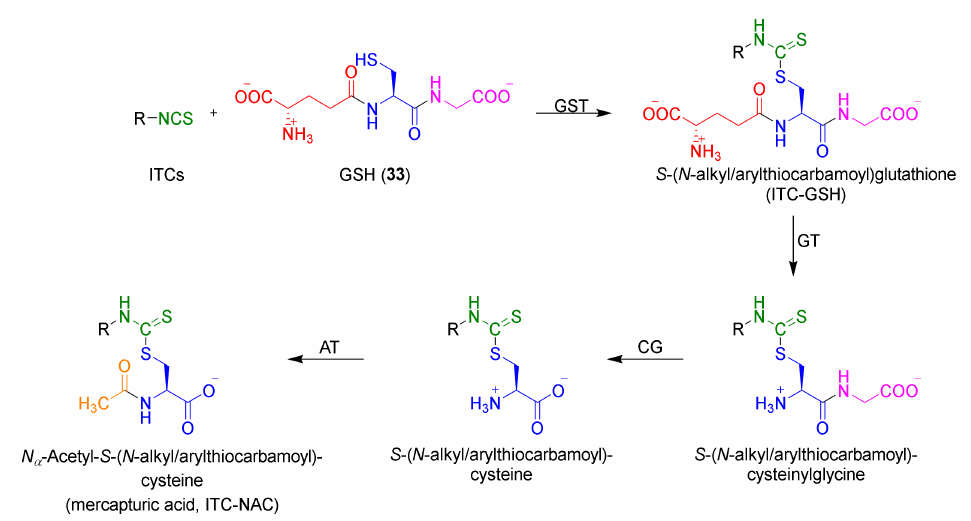
Figure 6. Metabolism of ITCs via the mercapturic acid pathway. R, an aliphatic or aromatic substituent.